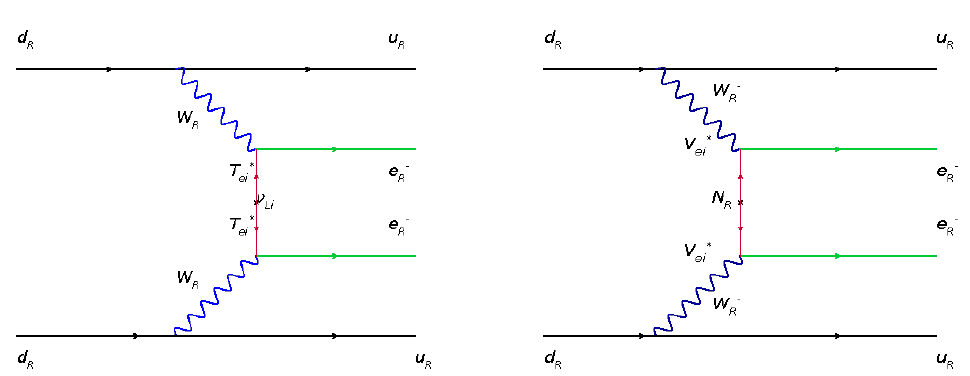
Figure 2 . Feynman diagrams corresponding to neutrinoless double beta decay due to (cid:23) (cid:0) W R (cid:0) W R , , N (cid:0) W R (cid:0) W R contributions.